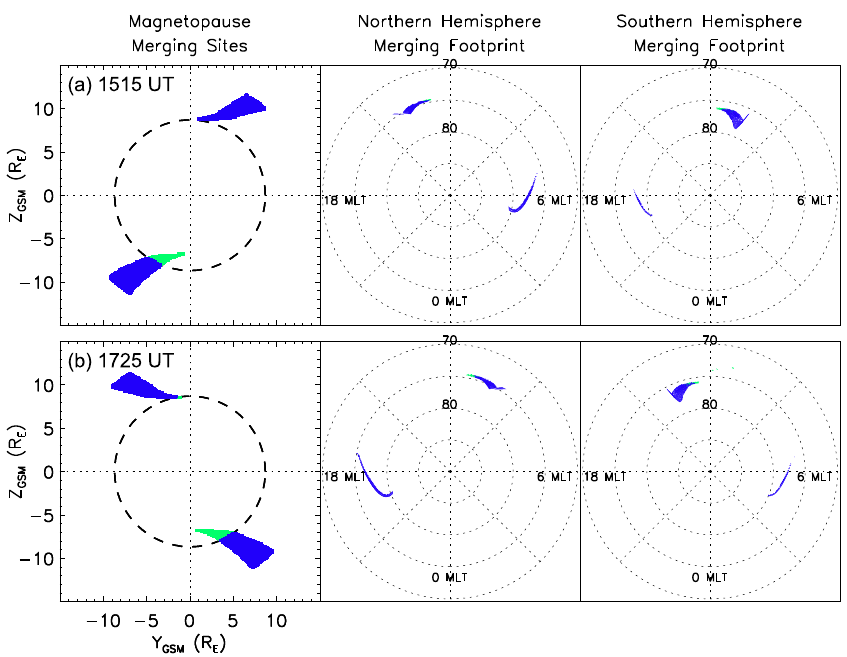
Fig. 10. The y - z GSM projection of the antiparallel merging regions on a modelled magnetopause, according to the method of Coleman et al. (2001) for (a) 15:15 UT and (b) 17:25 UT. The dashed circle denotes the boundary between sub-Alfvénic and super-Alfvénic flow regions. The merging footprint plots illustrate where the antiparallel merging sites map down to the northern and southern ionospheres, as a function of magnetic latitude and local